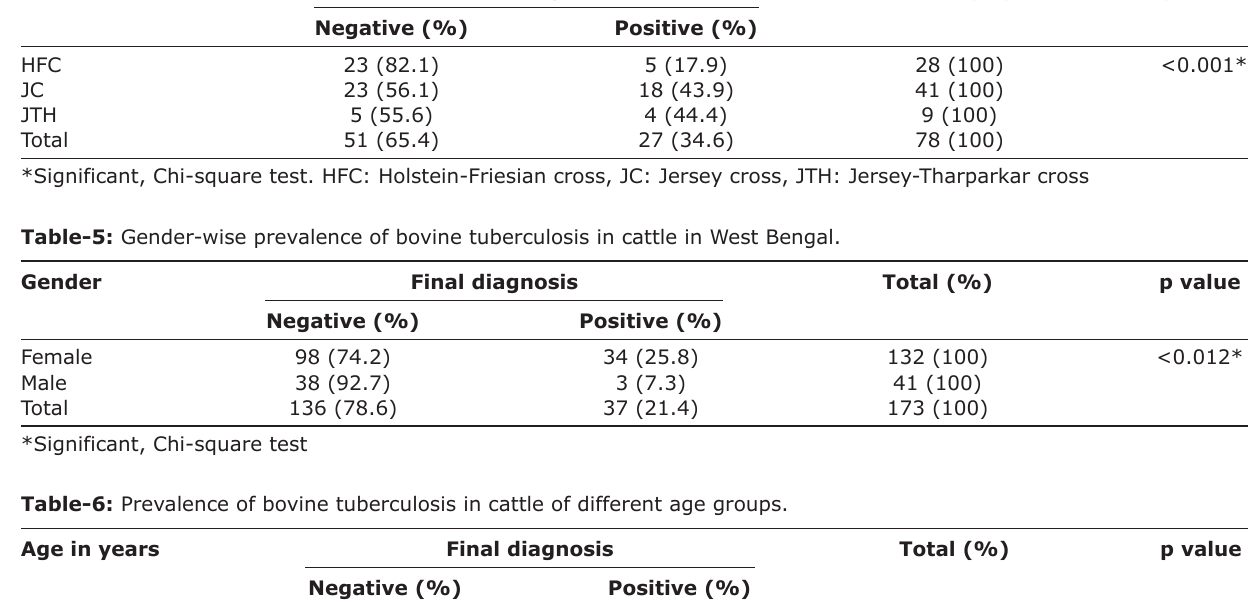
Table-4: Prevalence of bovine tuberculosis in different exotic crossbred cattle in West Bengal. Cattle breed